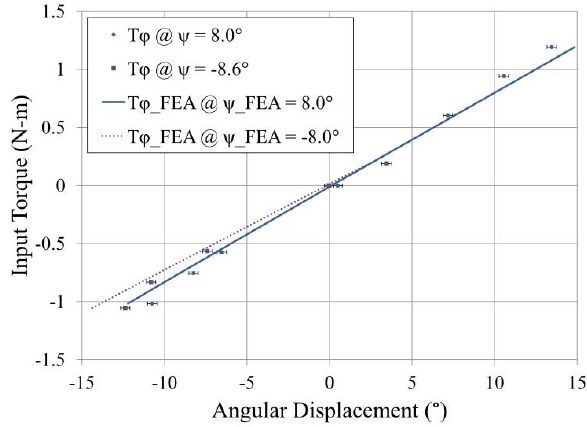
Figure 11. Comparison of measured and predicted input torques ( T φ ) at two values of ψ for the titanium